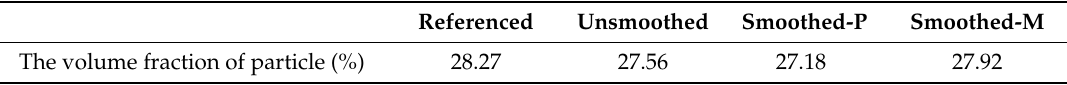
Figure 5. Comparison of four mesh modes: ( a ) reference model; ( b ) unsmoothed model; ( c ) smoothed model-particle enhanced; ( d ) smoothed model-matrix enhanced. Table 1. Volume fractions of particles in different models.